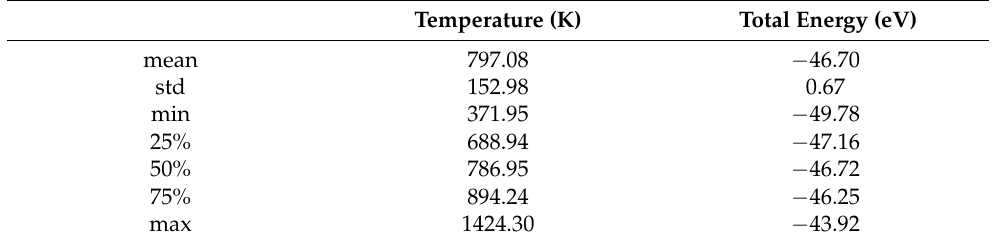
Table 4. Statistical analysis of energy fluctuations in structure II during LAMMPS MD